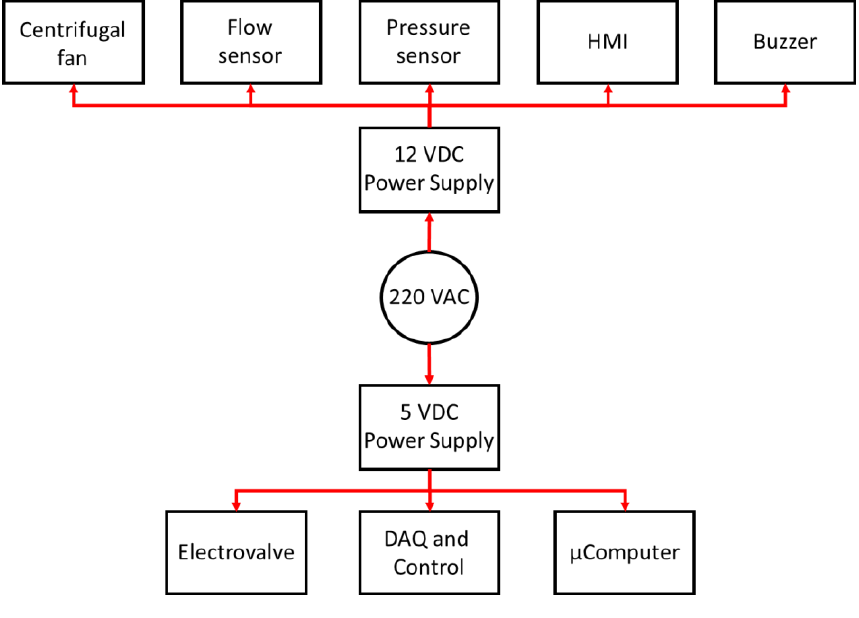
Table 1. Main parameters of the ventilator components.